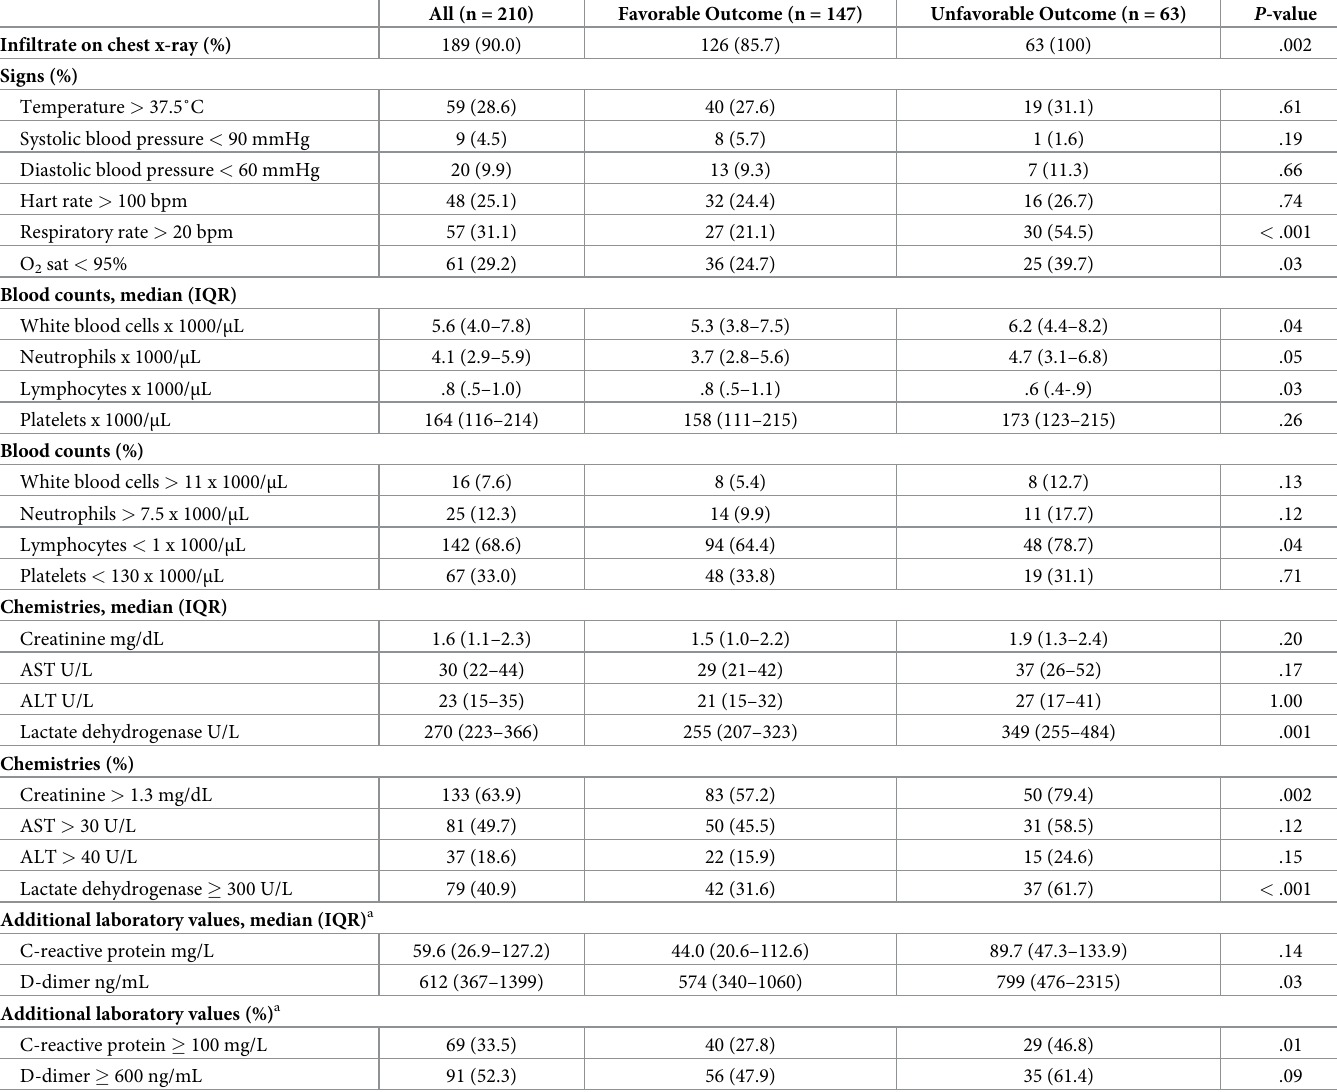
Table 2. Initial chest x-ray imaging features, hemodynamic, and laboratory values in all patients and by clinical outcome at final follow-up in all patients and by clinical outcome at final follow-up. All (n =